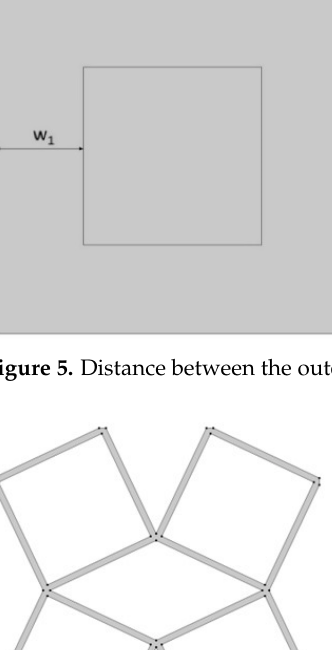
Figure 5. Distance between the outer and inner square in the unit.